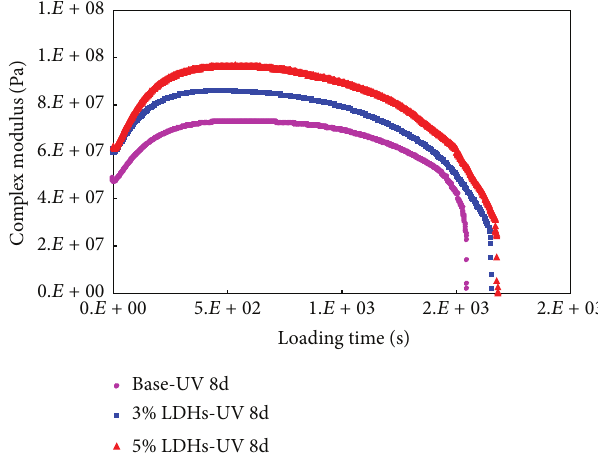
Figure 7: Fatigue life as the function of stress level 0.8MPa after UV 8d